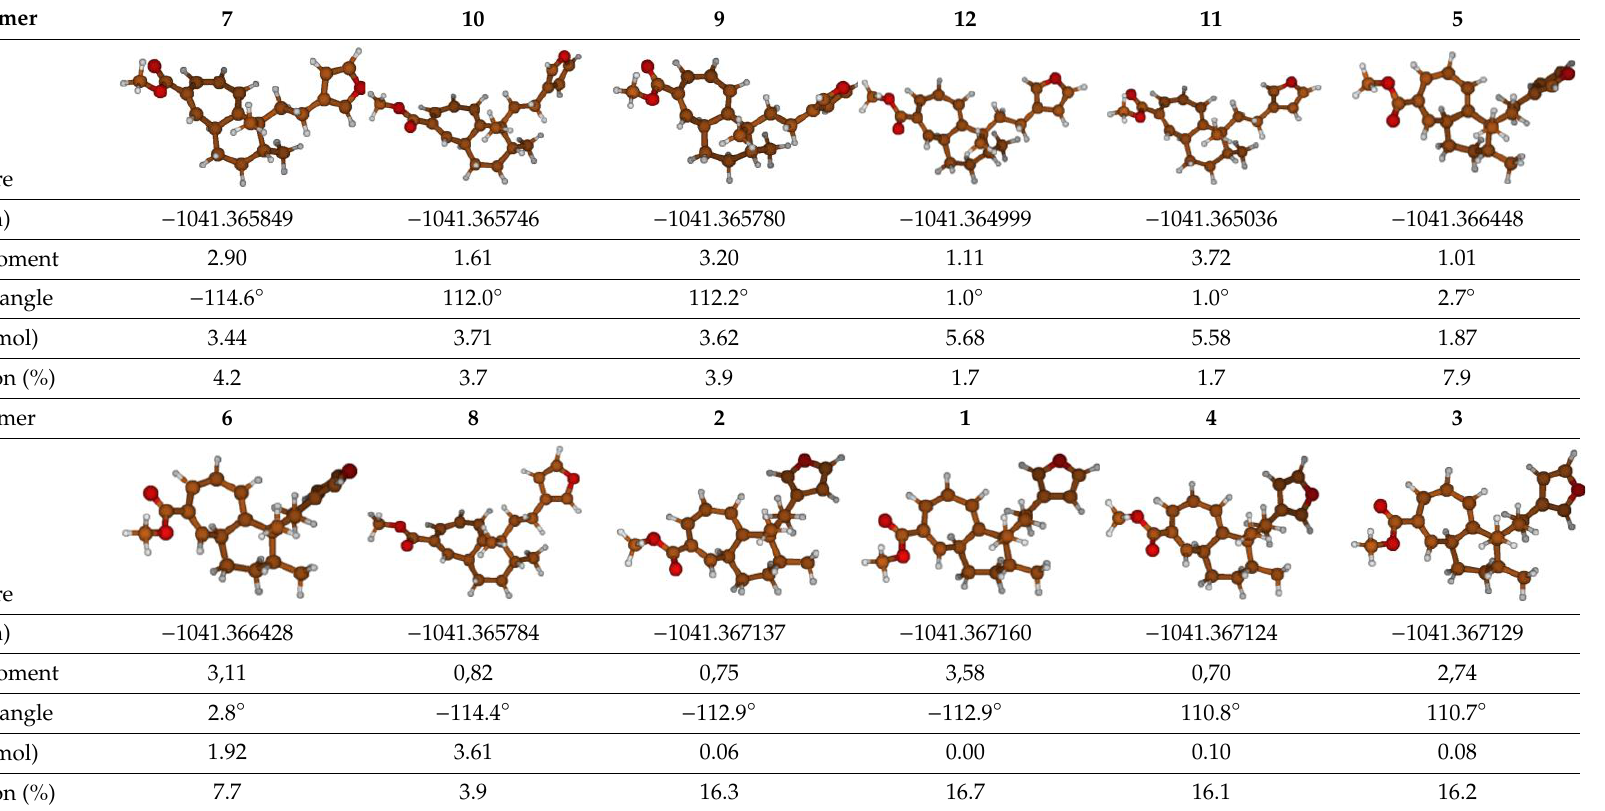
Table 8. Calculated B3LYP/6-311+G(d,p) Energies a , Dipole moments (Debye), relatives Energies a , (C13-C14-C15-C18) dihedral angle, equilibrium population at 25°C and figures of conformations 1-12 of the 1 S ,8 R ,9 R isomer of methyl iso-dodovisate A ( 3 ).